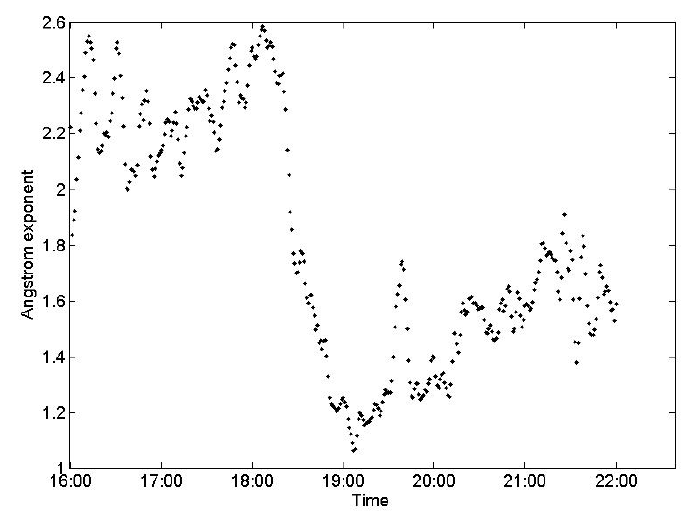
Figure 9. Change of Angstrom exponent with time.